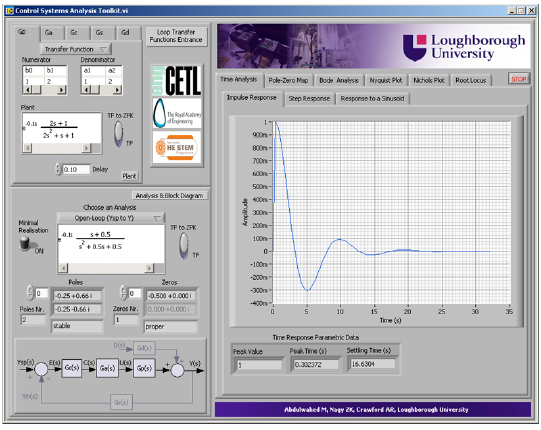
Figure 3. The Graphical User Interface (GUI) of the Control Systems Analysis Toolkit (CSAT).